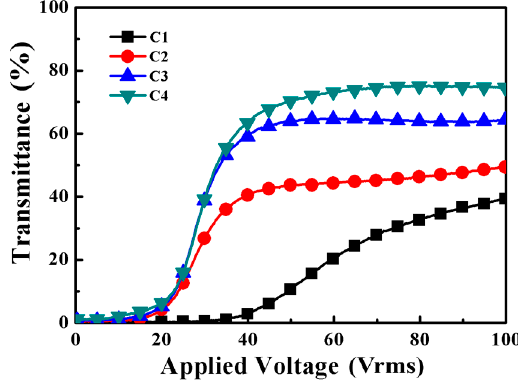
Figure 8. The transmittance-applied voltage curves of samples C1–C4.